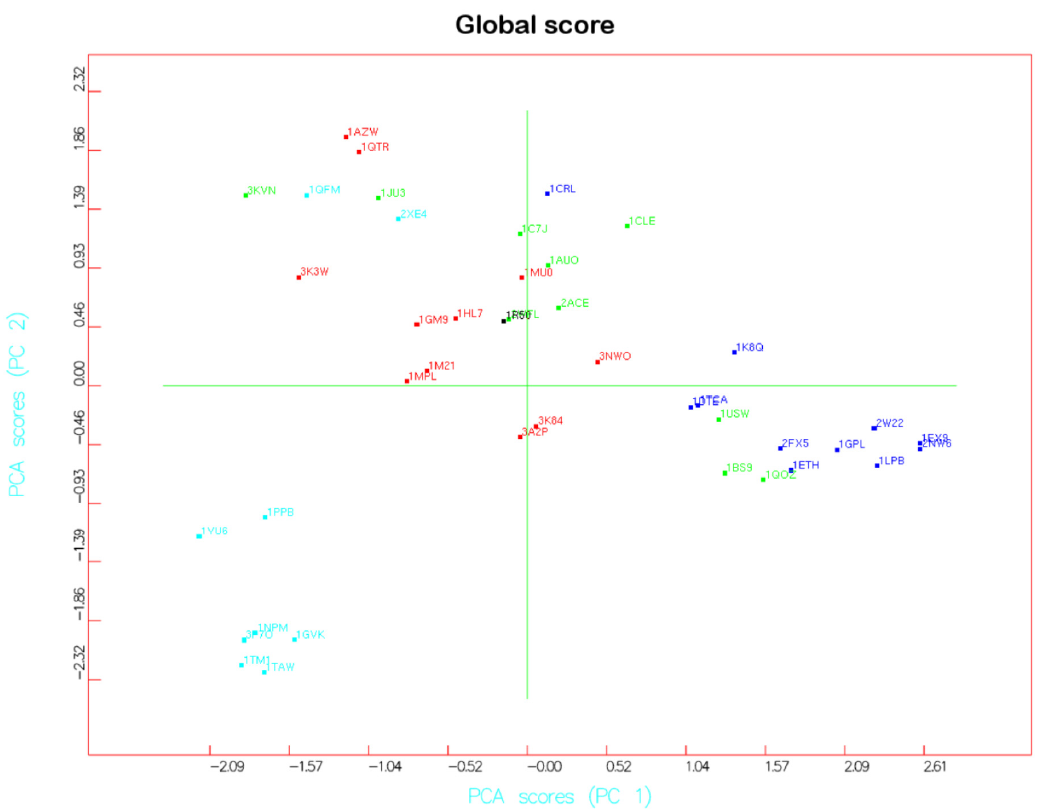
Figure 2. BioGPS of 43 serine hydrolases, for BSLA the data of pdb 1R50 were utilized (global score). Each analyzed enzyme structure is placed within a multidimensional space. Relative distances between each enzyme and all the other enzymes are determined by a statistical principal component analysis. The pdb codes of the processed enzyme structures are indicated in different colors according to their class: lipases in blue, amidases in red, proteases in cyan and esterases in green; the BSLA structure is in black.